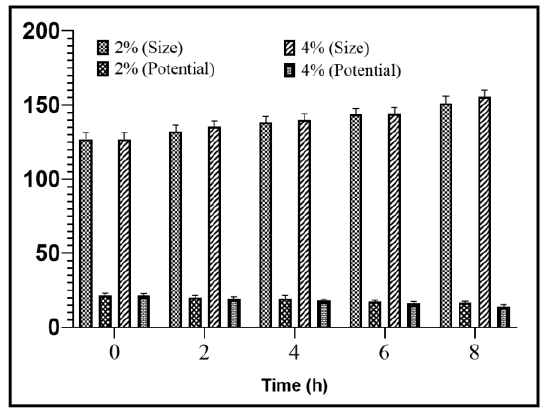
Figure 13. Interaction of MIL-101(Fe) with the serum protein.